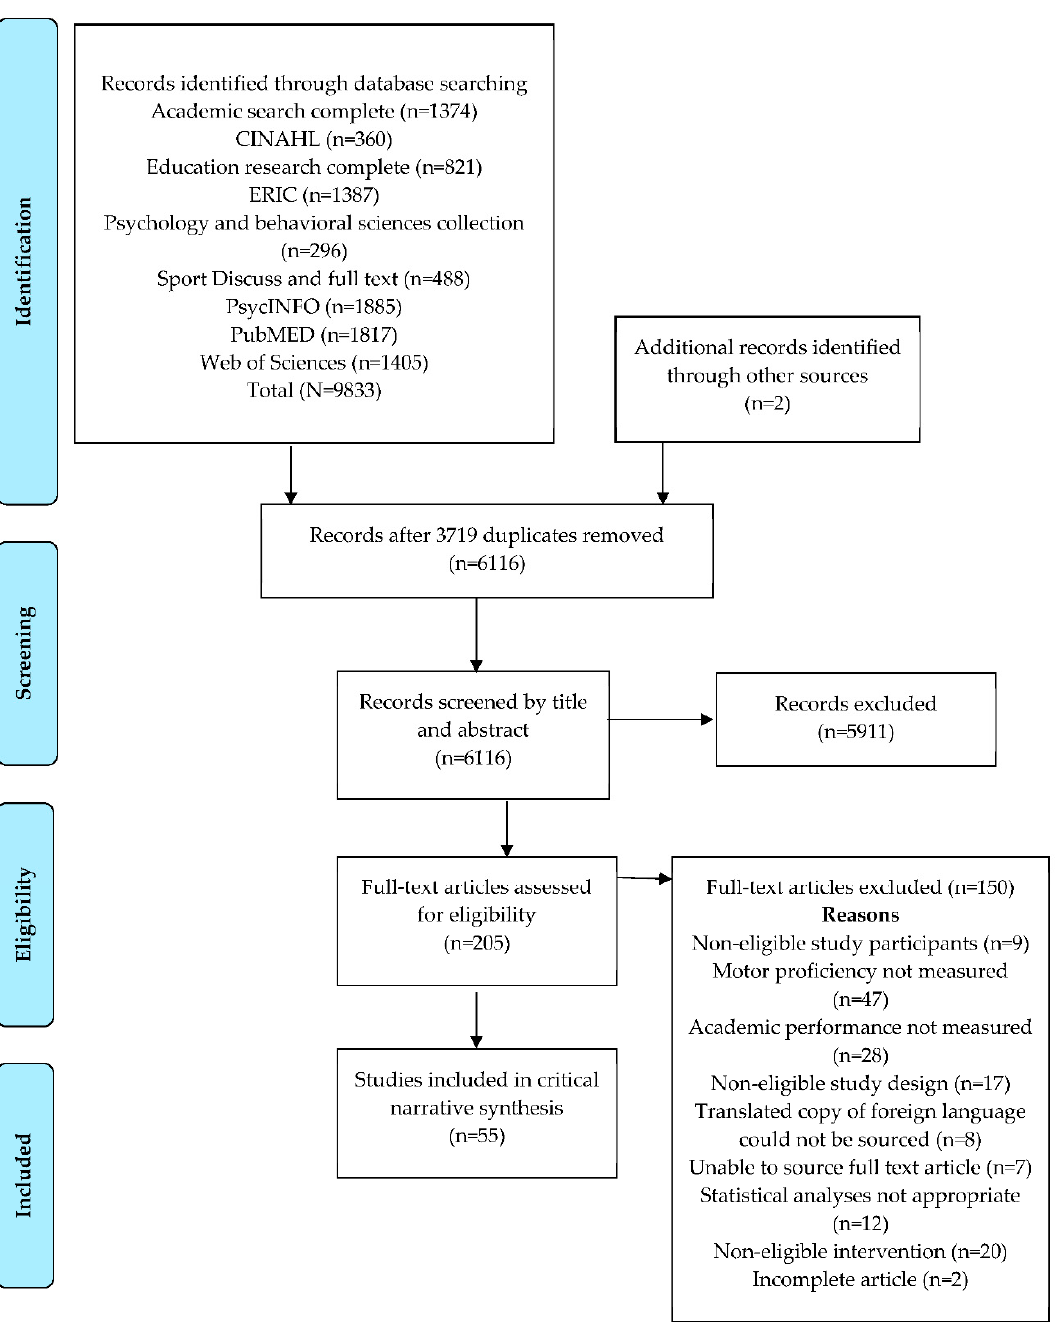
Figure 1. Preferred Reporting Items for Systematic Reviews and Meta-Analyses (PRISMA) flow diagram [26] depicting results of the search, screening, and selection processes.